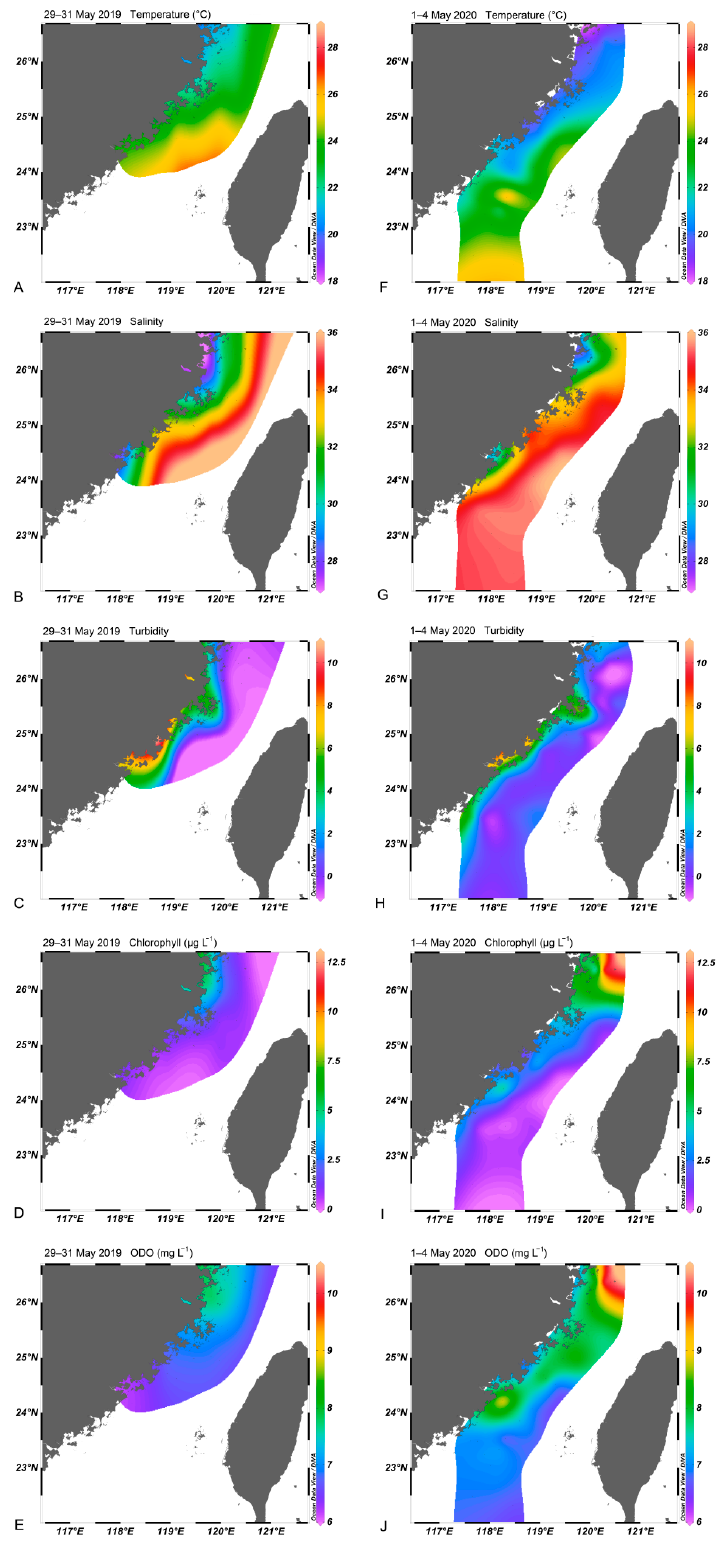
Figure 9. Water temperature ( ◦ C) ( A ), salinity ( B ), turbidity (NTU) ( C ), chlorophyll ( µ g L − 1 ) ( D ), and dissolved oxygen (mg L − 1 ) ( E ) in the Taiwan Strait in May 2019. Water temperature ( ◦ C) ( F ), salinity ( G ), turbidity (NTU) ( H ), chlorophyll ( µ g L − 1 ) ( I ), and dissolved oxygen (mg L − 1 ) ( J ) in the Taiwan Strait in May